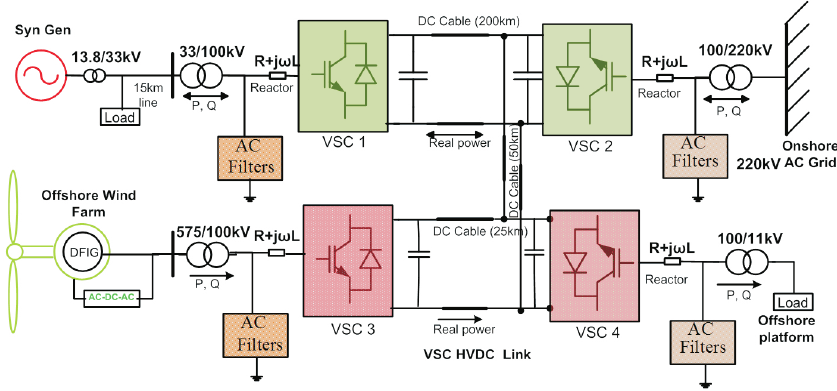
Figure 1: MTDC system for offshore wind farm and oil platform